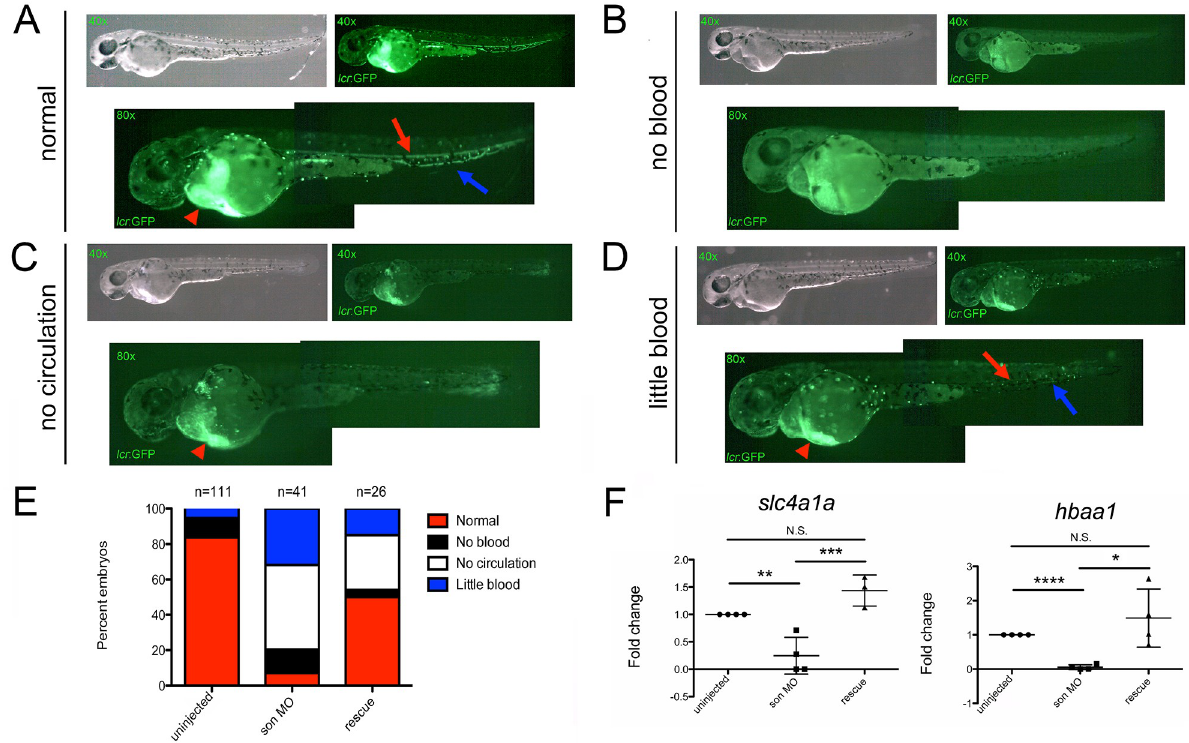
Fig 1. Reduction in son results in impaired erythropoiesis. Representative images of 48hpf lcr :GFP embryos injected with son MO at the one-cell- stage of development show four common phenotypic categories associated with son MO injection. Category titles are listed to the left of each image. Brightfield images are shown in top left (40x), and fluorescent images are shown in top right (40x). Zoomed in fluorescent images are shown below (80x); each green dot in the animal is a labelled RBC. Fluorescent “trails” of green are cells moving in the vasculature. Red arrows indicate RBCs flowing though the dorsal aorta, and blue arrows indicate RBCs flowing back to the heart through the caudal vein. Red arrowheads indicate large numbers of RBCs pooled in the ducts of Cuvier, located on the yolk ball. ( A ) Representative images of normal RBC numbers and blood flow. ( B ) Representative animals with no RBCs (no blood), ( C ) no RBCs circulating in the animal (no circulation), and ( D ) reduced numbers of RBCs, some of which are circulating (little blood). ( E ) Quantitation of phenotypes shown. Number of embryos analyzed is shown above the chart. ( F ) qRT-PCR for slc4a1a (left) and hbaa1 (right) was performed. Each point represents ten embryos randomly selected from uninjected, MO-injected ( son MO), or MO-injected with son RNA (rescue) conditions that were analyzed by qRT-PCR. Middle lines represent mean and error bars represent SD. � represents p = 0.04, �� represents p = 0.02, ��� represents p = 0.004, ���� represents p < 0.001, N.S. represents no significance.